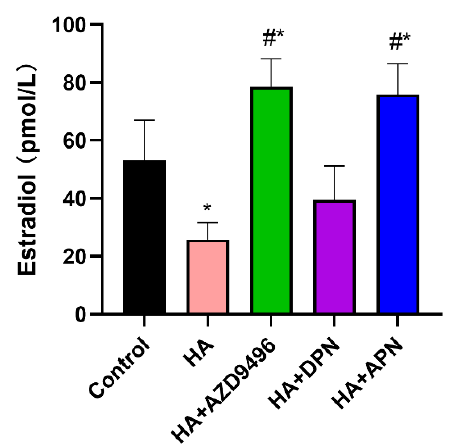
Figure 7. ELISA analysis for serum estradiol level. Fortification of APN and AZD9496 significantly increased serum 17 β -estradiol (E2) levels. The serum used in this experiment was obtained from the orbital sinus of mice. Data are presented as the mean ± SEM of at least three independent experiments. * p < 0.05 versus the control group, # p < 0.05 versus the HA group.